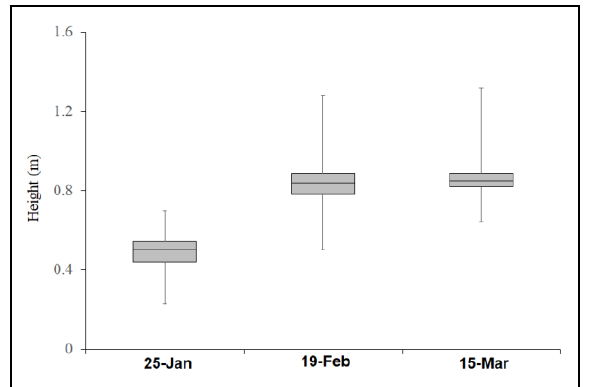
Figure 1. Location of the study area